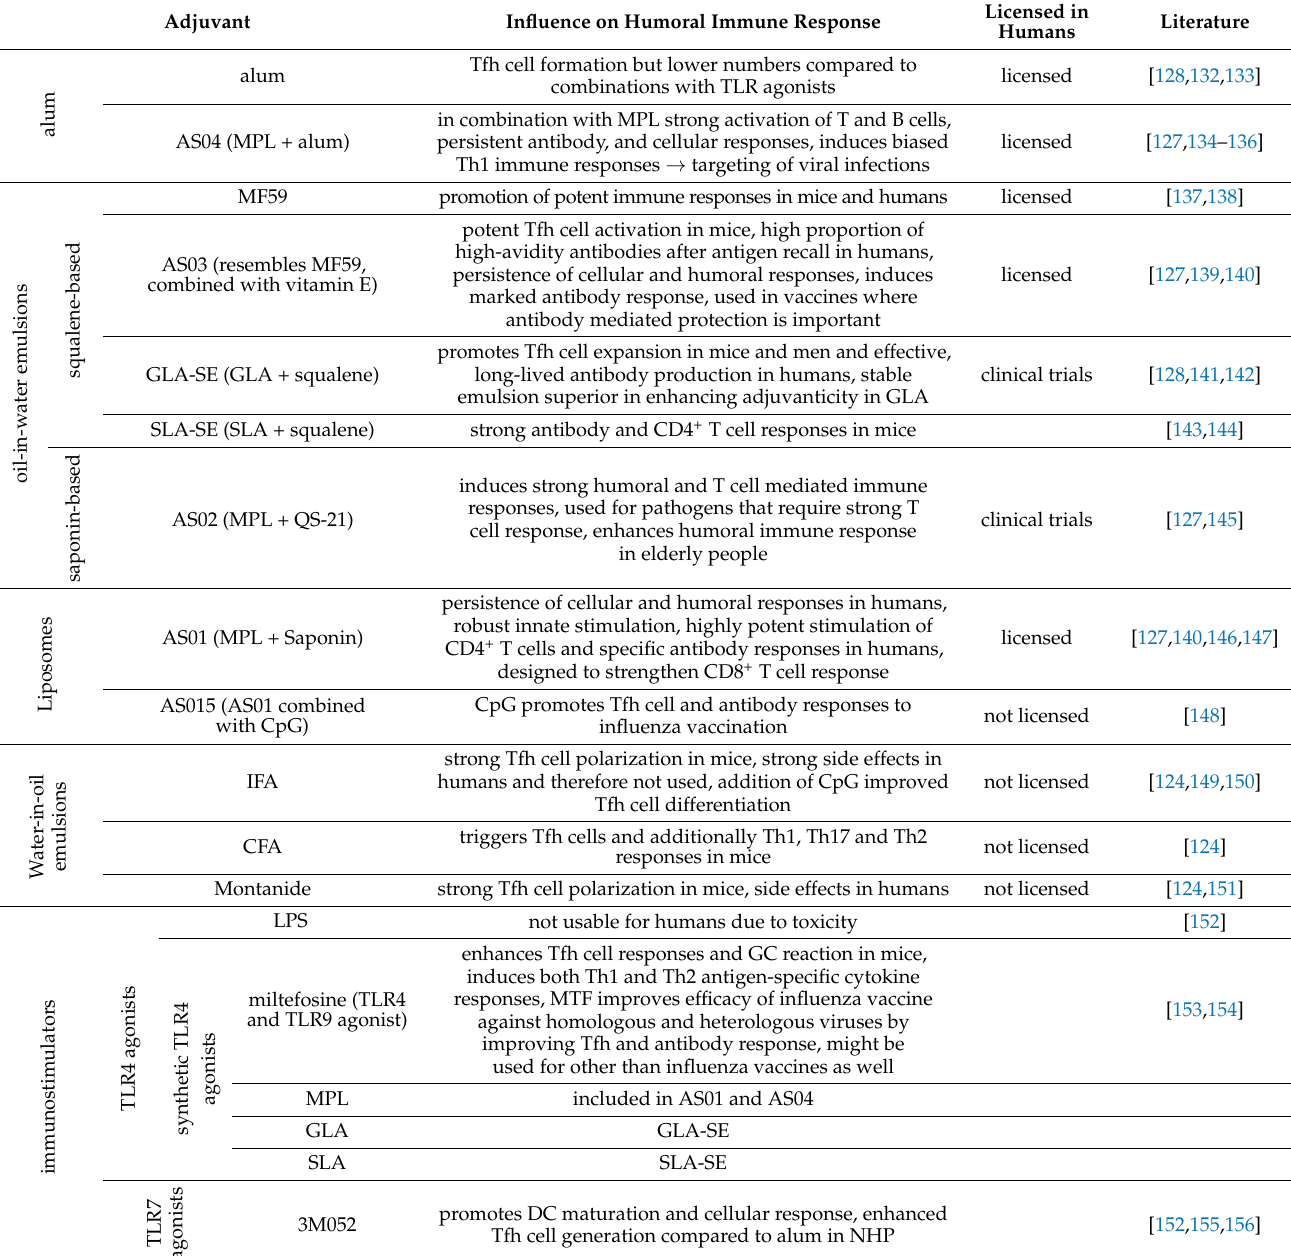
Table 1. Adjuvants and their influence on Tfh